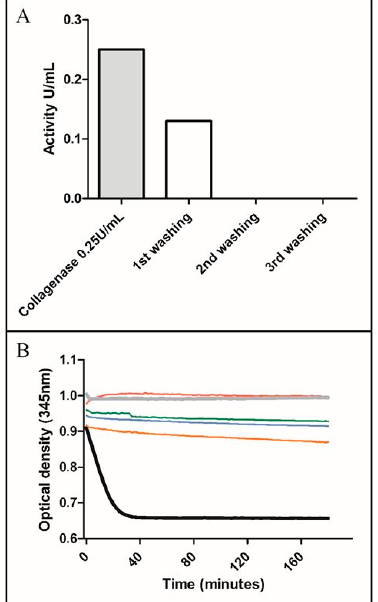
Figure 4. Kinetics of substrate degradation by collagenase . ( A ) A representative experiment of four enzyme activity assay replications: collagenase was undetectable from the second washing. ( B ) The optical density reflects degradation of the substrate by collagenase over time. The slope of the regression line was calculated for the second washings of four SVF preparations: SVF-A, SVF-B, SVF-C, and SVF-D, respectively: − 0.00003, − 0.0001, − 0.0001, and − 0.0002; slope of the positive control: − 0.0113; slope of the negative control: − 0.00002. Table 1. Di ff erences between LG and Celution protocols. LG: the developed SVF production process, named the person who originally developed it. NA: not